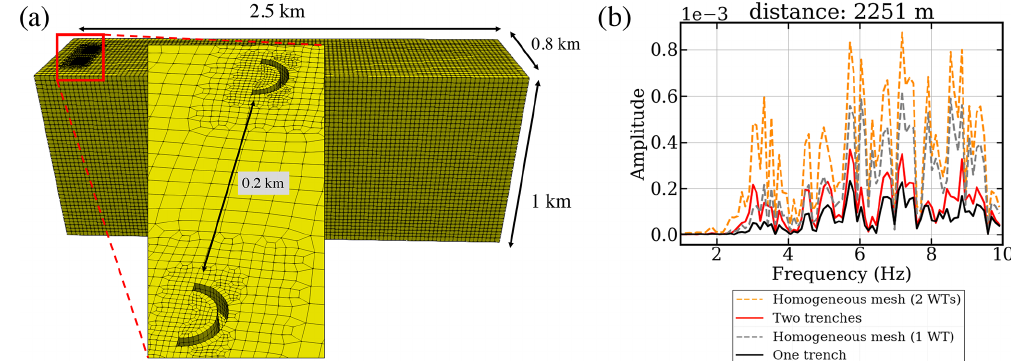
Figure 6. (a) Setup with two wind turbines, each with a half-circular trench in the direction of the seismic station. (b) The spectra of the model without trenches (dashed lines) and with trenches (solid lines). The orange and red lines indicate the case of two wind turbines, and the gray and black lines those of one wind turbine.